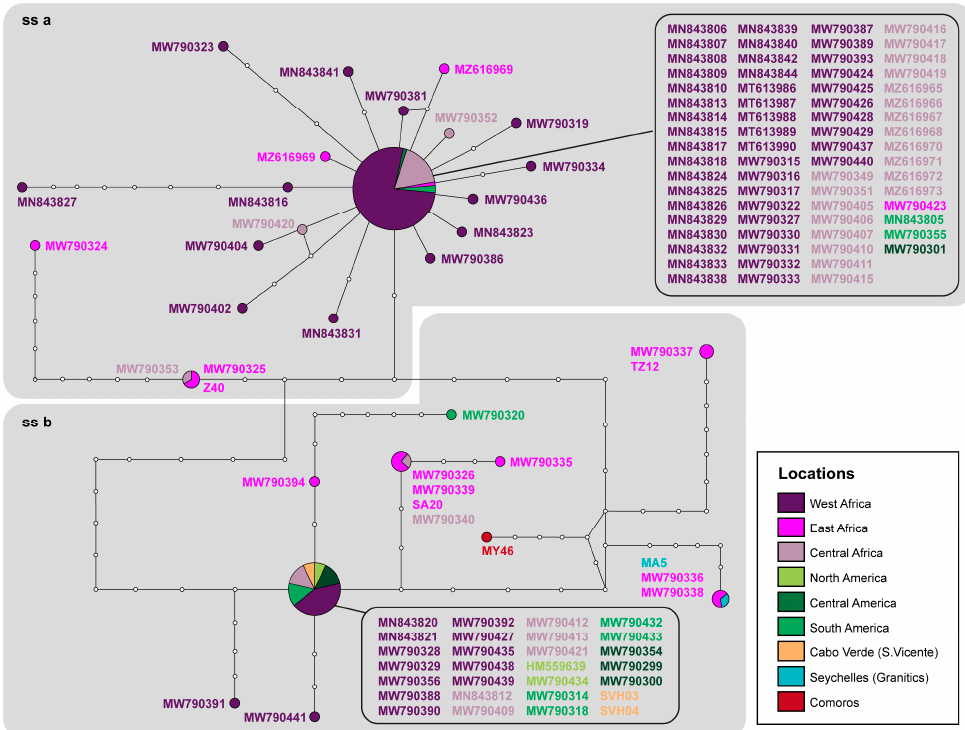
Figure 3. Haplotype network for ND2 mitochondrial marker. White dots along the branches represent missing or unsampled haplotypes. Haplotypes are colour coded geographically (for details, see Table S1) as well as the accession numbers/tissue codes which are given next to the nodes or in boxes. The circle size represents the haplotype frequency. The grey boxes in the network delimit H. mabouia ss a ( ss a ) and H. mabouia ss b ( ss b ), following the ML tree and a previous study [10].